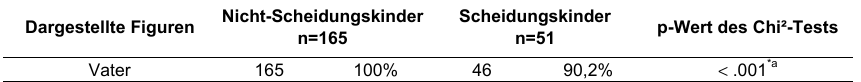
Tabelle 2 6 : Abbildung des Vaters Dargestellte